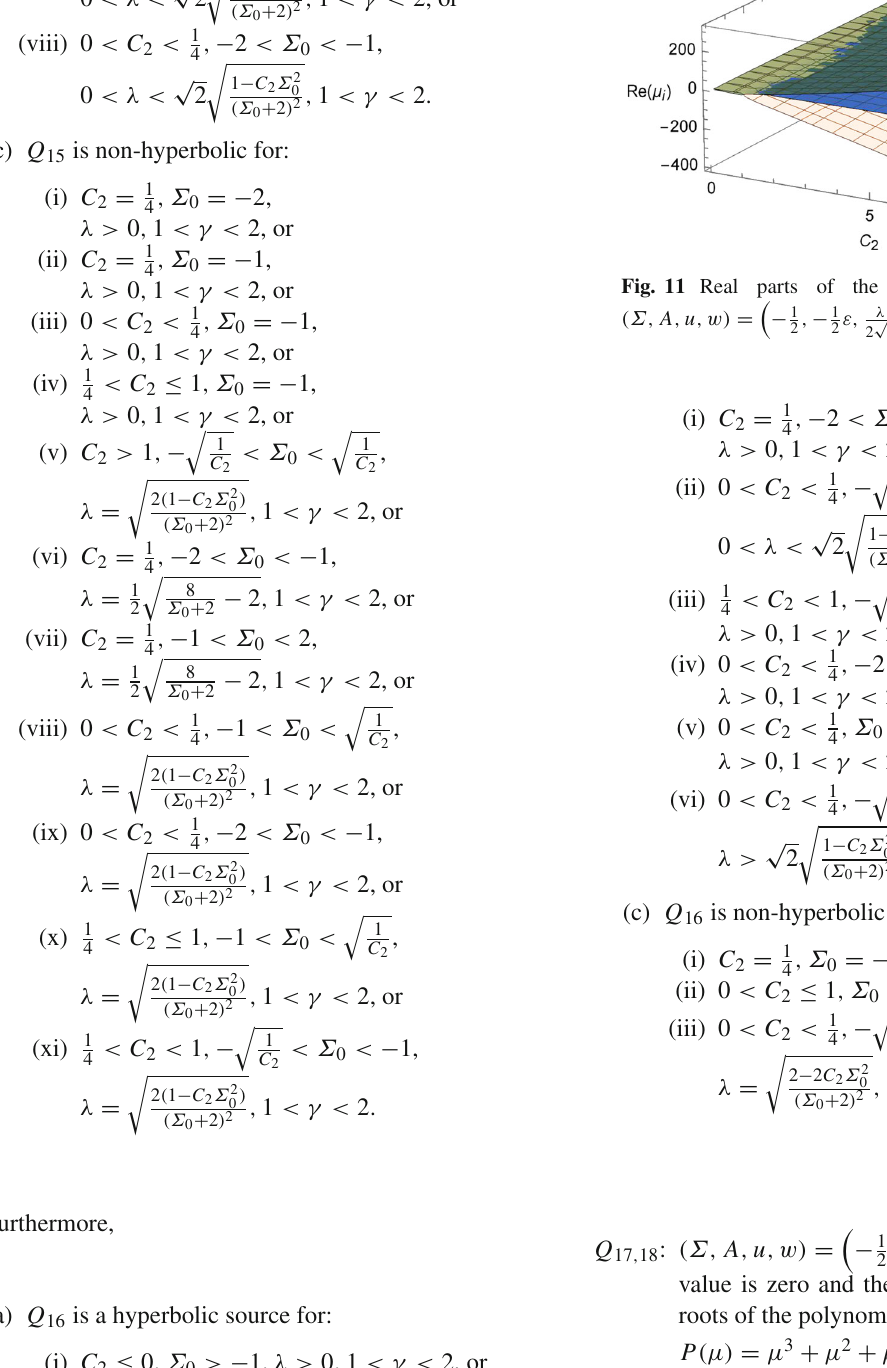
+ 1. It is either a non-hyperbolic saddle or a C 2 + λ 2 2 center depending on the choice of parameters. Figure 11 graphically represents the real part of the μ i corre- sponding to the equilibrium point Q 17 , 18 , illustrating that the equilibrium points have saddle behavior or they are